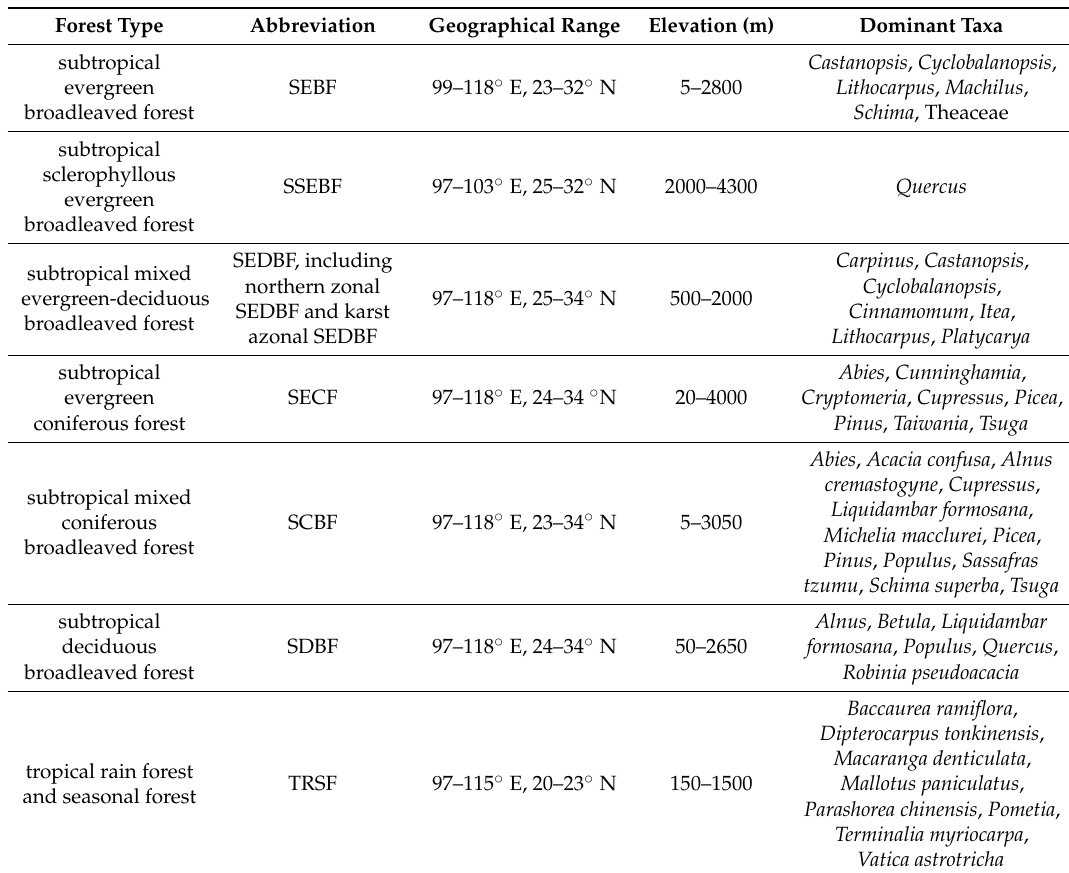
Table 1. Major forest types in Southwestern